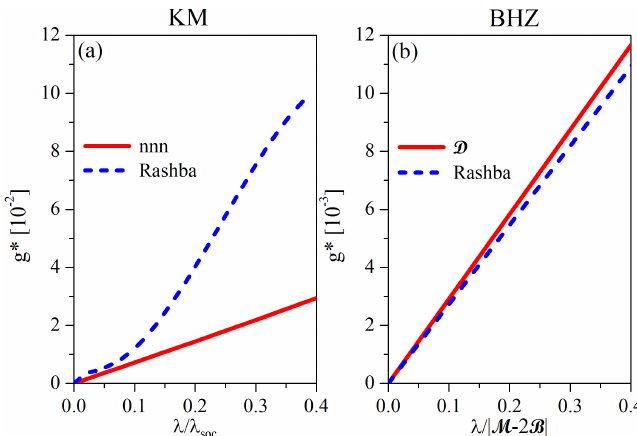
Figure 4: (Color online) Effective g -factors as a function of the PHS breaking term parameter λ for the KM [ panel (a) ] , we used next nearest neighbor and Rashba, while for the BHZ model [ panel (b) ] , the assymetric mass D and the Rashba spin orbit coupling. For the parameters used in the calculation, we refer to the main